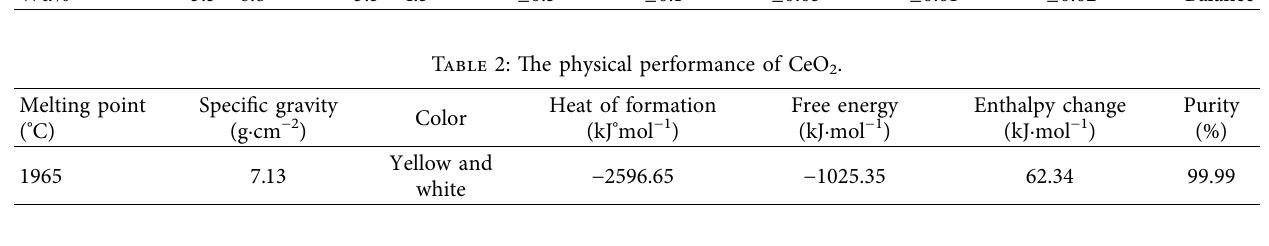
Table 2: The physical performance of CeO